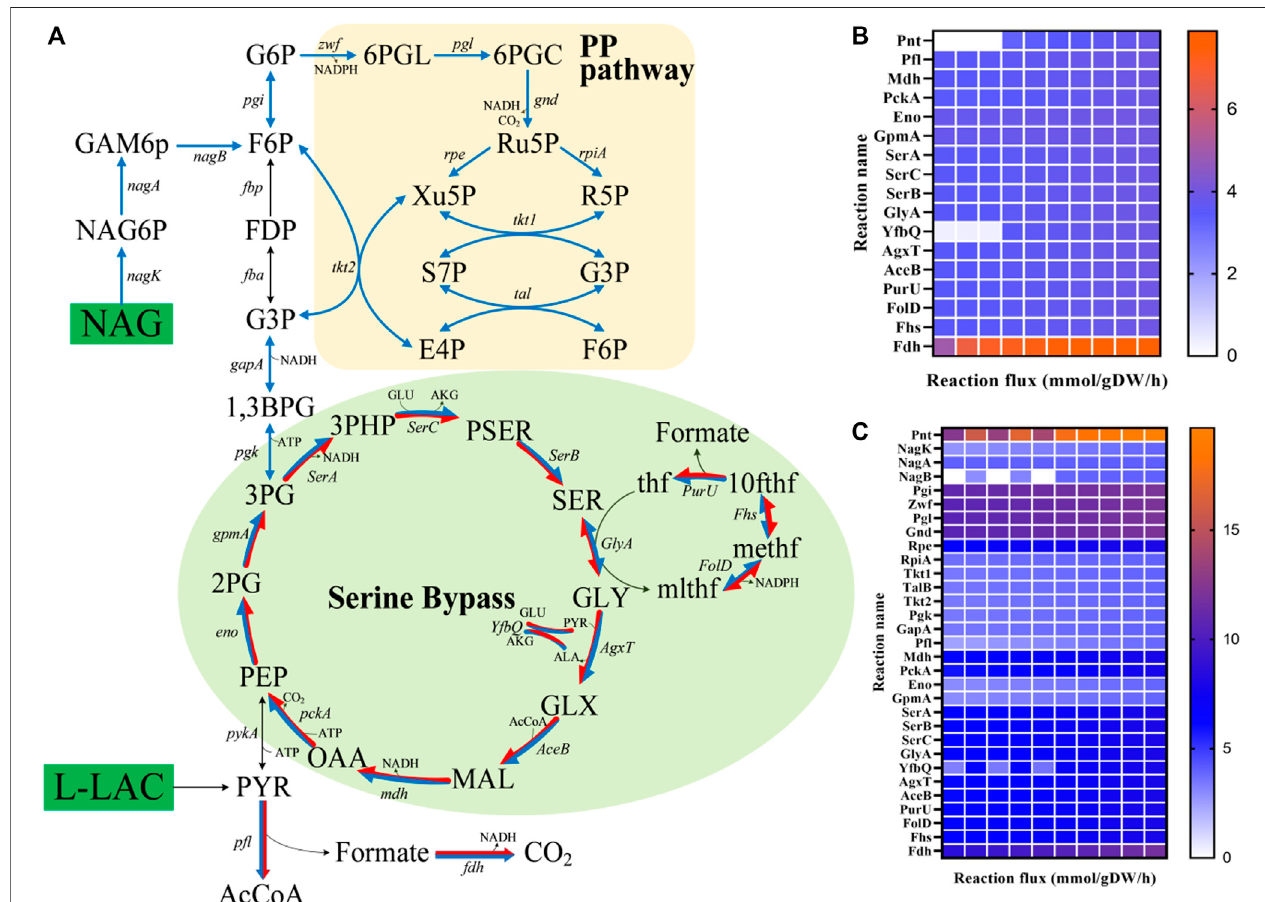
FIGURE7| FSEOF analysisfor NADH regeneration. (A) Distributionoftargets predicted by theFSEOFalgorithm. Thegreenmodule represents theserinebypass, and theorange modulerepresentsthepentosephosphate pathway (PPpathway). Bluearrows represent overexpressiontargetswhenNAG wasused asthesubstrate, and red arrows represent overexpression targets when L -lactate was used as the substrate. (B) Reaction fl ux changes of targets with an L -lactate uptake rate 4.06 mmol/gDW/h. (C) Reaction fl uxchangesoftargetswithanNAGuptakerateof4.06mmol/gDW/h.Abbreviation:f6p, D -fructose6-phosphate;fdp, D -fructose 1,6-bisphosphate; g3p, glyceraldehyde 3-phosphate; 1,3bpg, 1,3-Bisphospho- D -glycerate; 3pg, 3-phospho- D -glycerate; 2pg, 2-phospho- D -glycerate; pep, phosphoenolpyruvate; pyr, pyruvate; g6p, D -glucose 6-phosphate; 6pgl, 6-phospho-D-glucono-1,5-lactone; 6pgc, 6-phospho- D -gluconate; accoa, acetyl-CoA; akg, 2-oxoglutarate; oaa, oxaloacetate; mal, malate; glx, glyoxylate; 3php, 3-phosphonooxypyruvate; pser, phosphoserine; 10fthf, 10-formyltetrahydrofolate; methf, 5,10- methenyltetrahydrofolate; mlthf, 5,10-methylenetetrahydrofolate; Ser, L -serine; thf, 5,6,7,8-tetrahydrofolate; ru5p_D, D -ribulose 5-phosphate; xu5p_D, D -xylulose